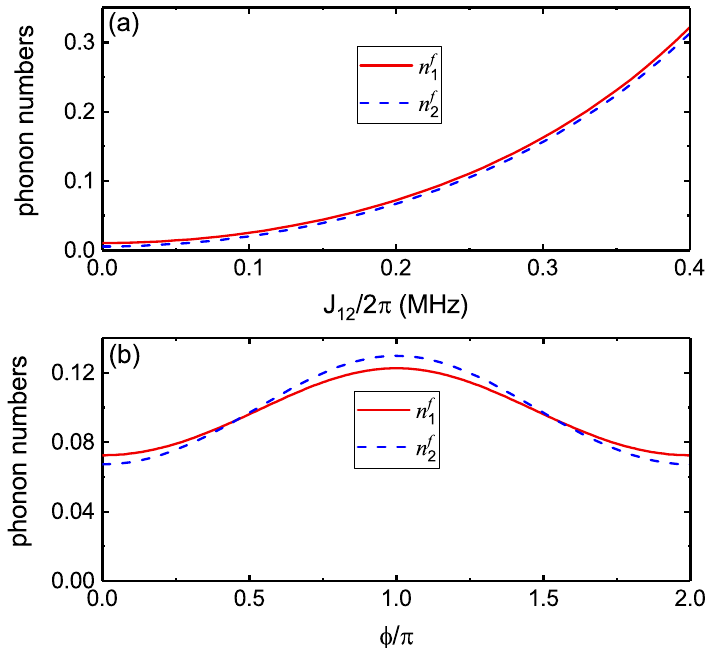
Figure 7. The final average phonon numbers n f optomechanical coupling strength J 12 /2 π with φ = 0 and ( b ) the phase difference φ / π with J 12 /2 π = J 21 /2 π = 0.2 MHz. The other parameters are the same as those in Figure